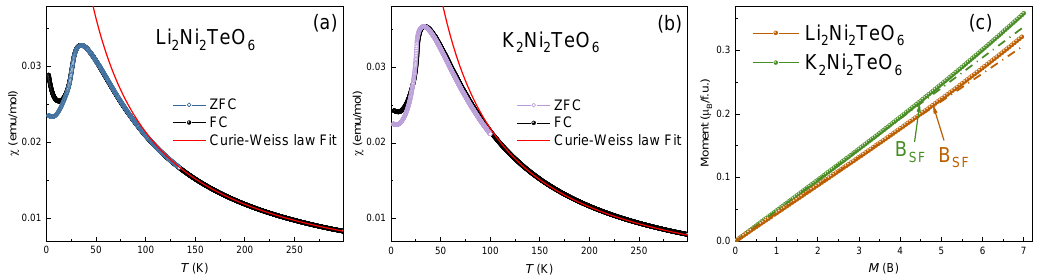
Figure 2. ZFC and FC magnetic susceptibilities of ( a ) Li 2 Ni 2 TeO 6 and ( b ) K 2 Ni 2 TeO 6 taken at B = 0.1 T. The solid lines are the fits by the Curie – Weiss law, dashed green lines — Rushbrook – Wood model fit. ( c ) Magnetizations of Li 2 Ni 2 TeO 6 and K 2 Ni 2 TeO 6 at T = 2 K. The fields of the spin – flop transition, B sf , are marked by arrows. Table 3. Parameters describing the magnetic subsystems of A 2 Ni 2 TeO 6 (A = K, Li) tellurates. Θ , K µ eff , µ B /f.u. T N , K B SF ,